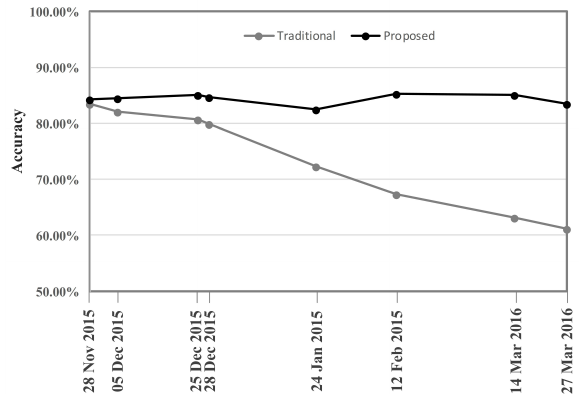
Figure 6. Rice mapping accuracies obtained by the traditional and proposed